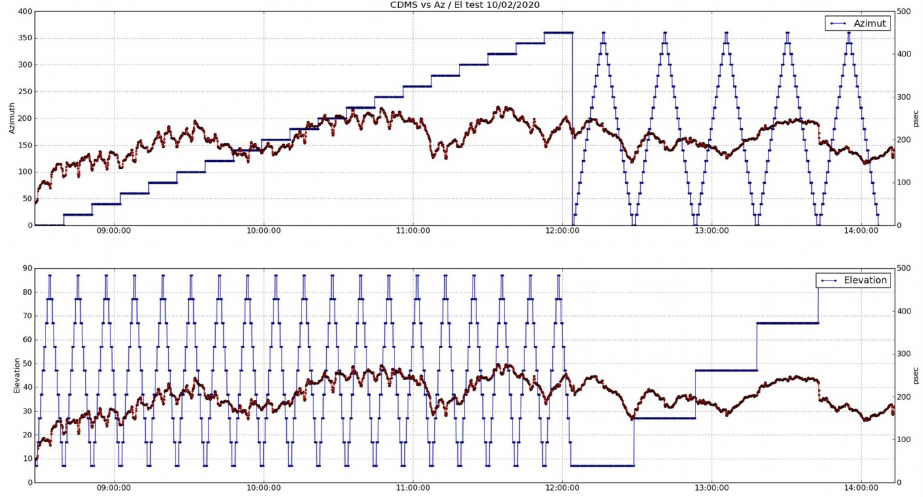
Figure 21. Time evolution of cable delay vs. azimuth and elevation angles.